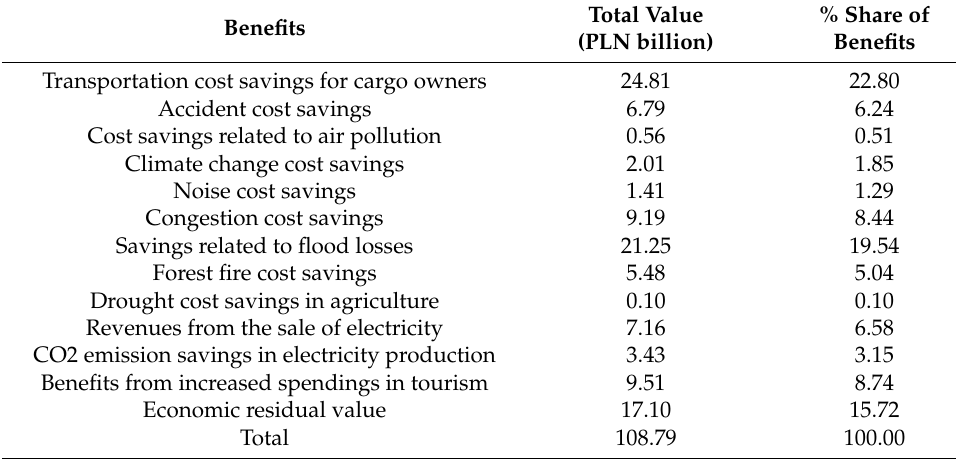
Total Value % Share of (PLN billion)